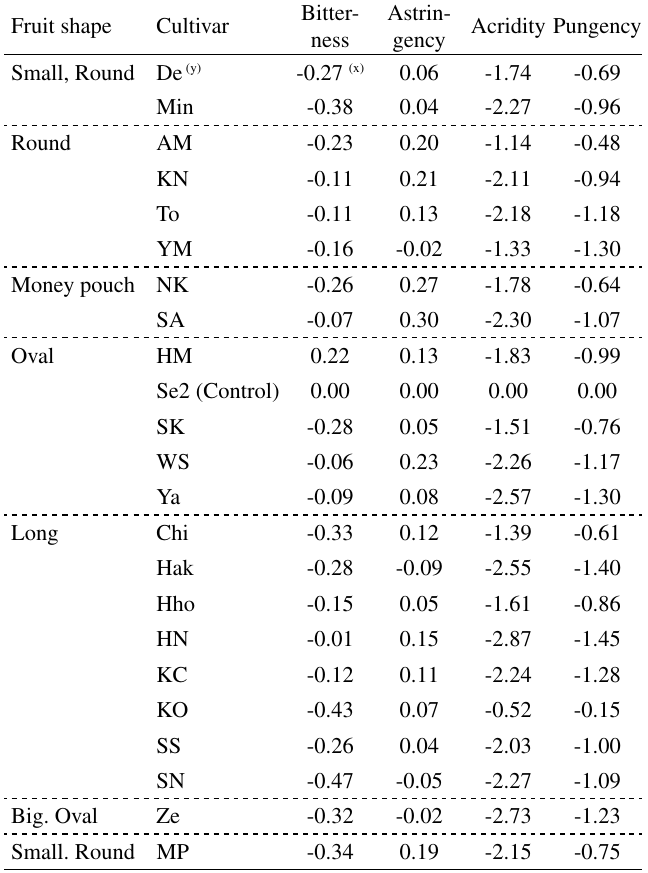
Table 3 - Evaluation of the taste of eggplant cultivars by taste sensor (z)